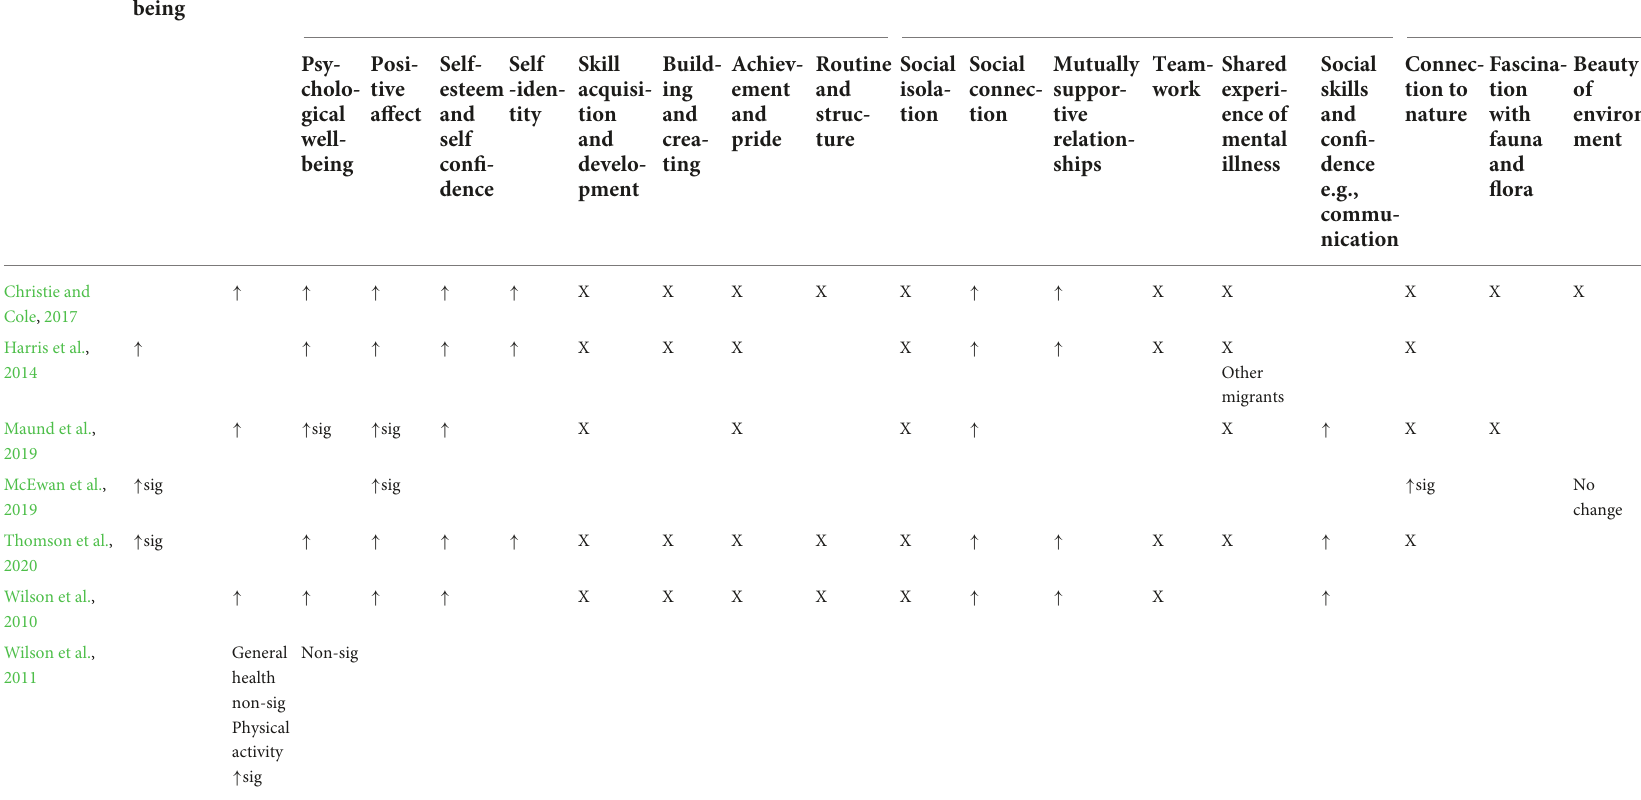
TABLE 5 Study results for biopsychosocial domains and environment